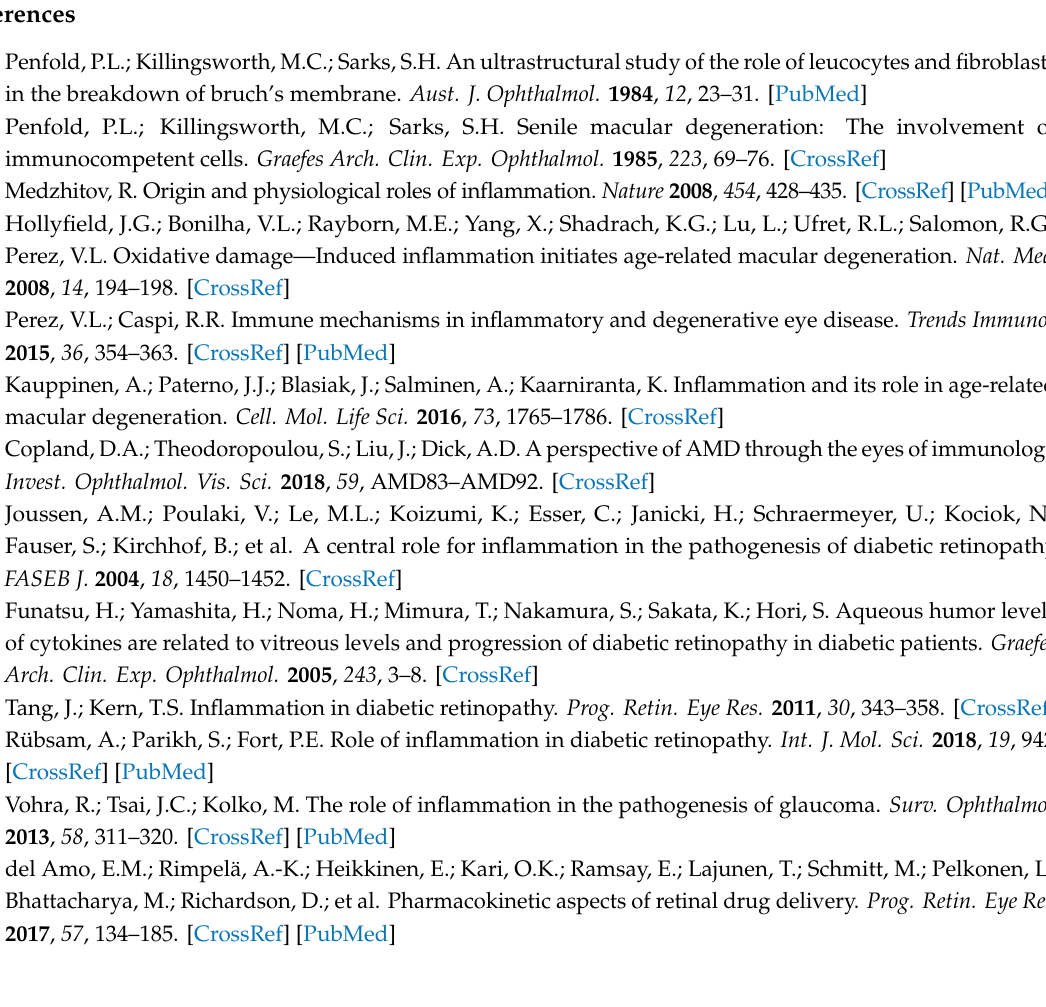
Figure S1: IL-6 knockdown in dividing ARPE-19 cells, 3 days after transfection. Video S1: PRO.avi. Video S2: